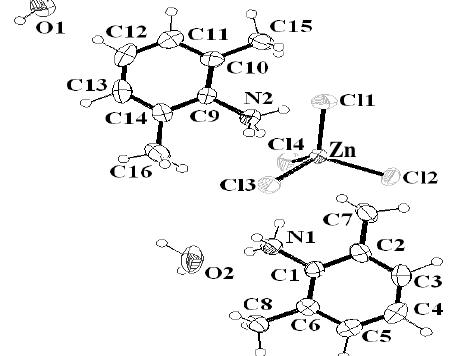
Figure 1. ORTEP representation of the molecular configuration of [2,6-(CH C H NH ] ZnCl .2H O, with atom numbering scheme and thermal ellipsoids at 40% of 6 3 3 2 4 2 probability.